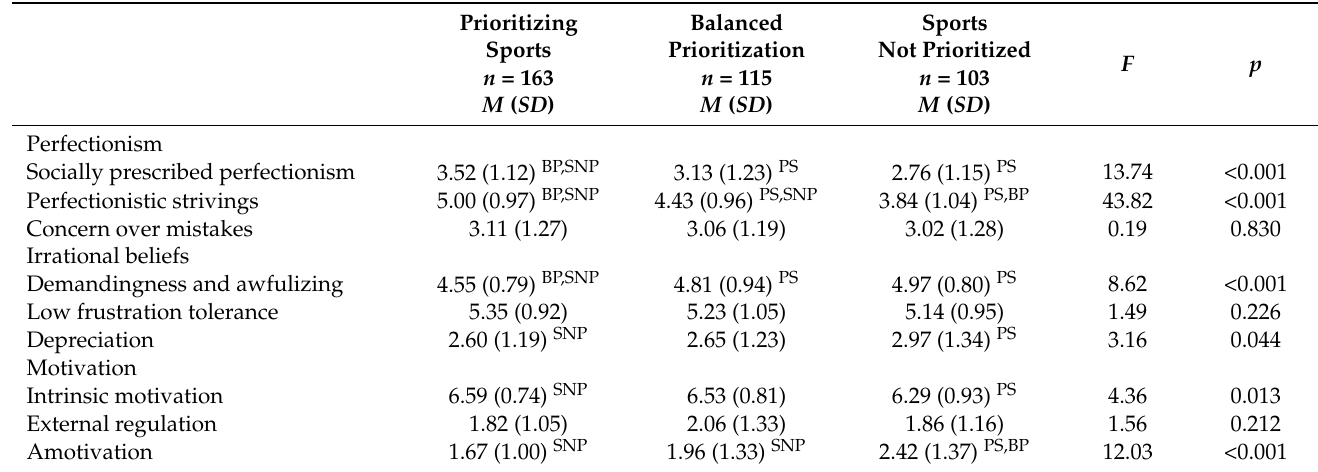
Table 2. Mean comparison of T2 perfectionism, irrational beliefs, and motivation of talented athletes based on future career expectancies.